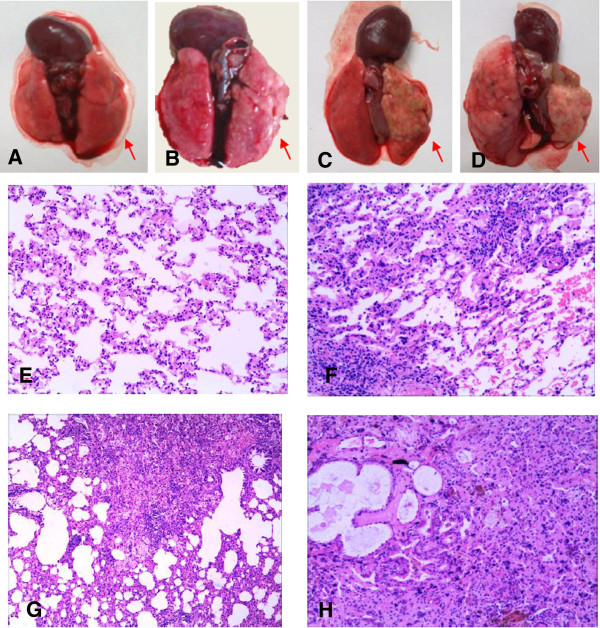
Photomicrographs illustrating the histological response of lungs of rats irradiated with 20 Gy after a post-exposure period of approximately 26 weeks (H&E, 100X). Gross examination of lungs at autopsy: (A) normal lung in non-irradiated rat; (B) 3 week; (C) 12 week; (D) 26 week; (E) Normal lung parenchyma and vessels in controls. (F) The third week after radiation shows the visibility of interstitial inflammatory edema and intra-alveolar hemorrhage; (G) The 12th week after radiation shows diffuse increase in alveolar septal thickening, vascular wall thickening and sclerosis, with focal necrosis and subsequent organization; (H) The 26th week after radiation shows fibroblast proliferation and increased collagen accumulation in the interstitial, as well as in the intra-alveolar space, and widespread loss of tissue architecture. (The right lung are indicated with arrowheads).